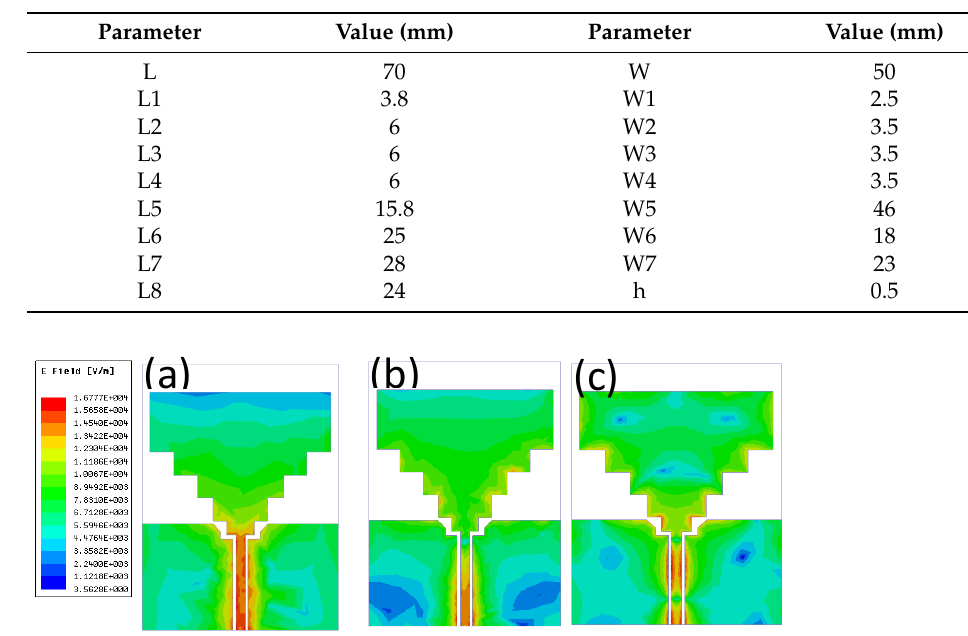
Table 2. Structural dimensions of the antenna.